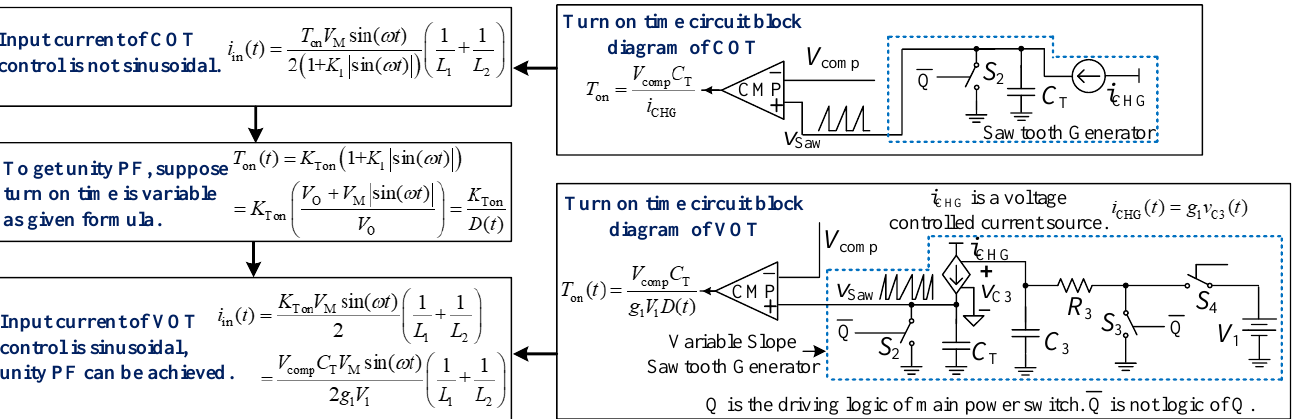
Figure 3. Block diagram for the developed procedure from COT control to VOT control.